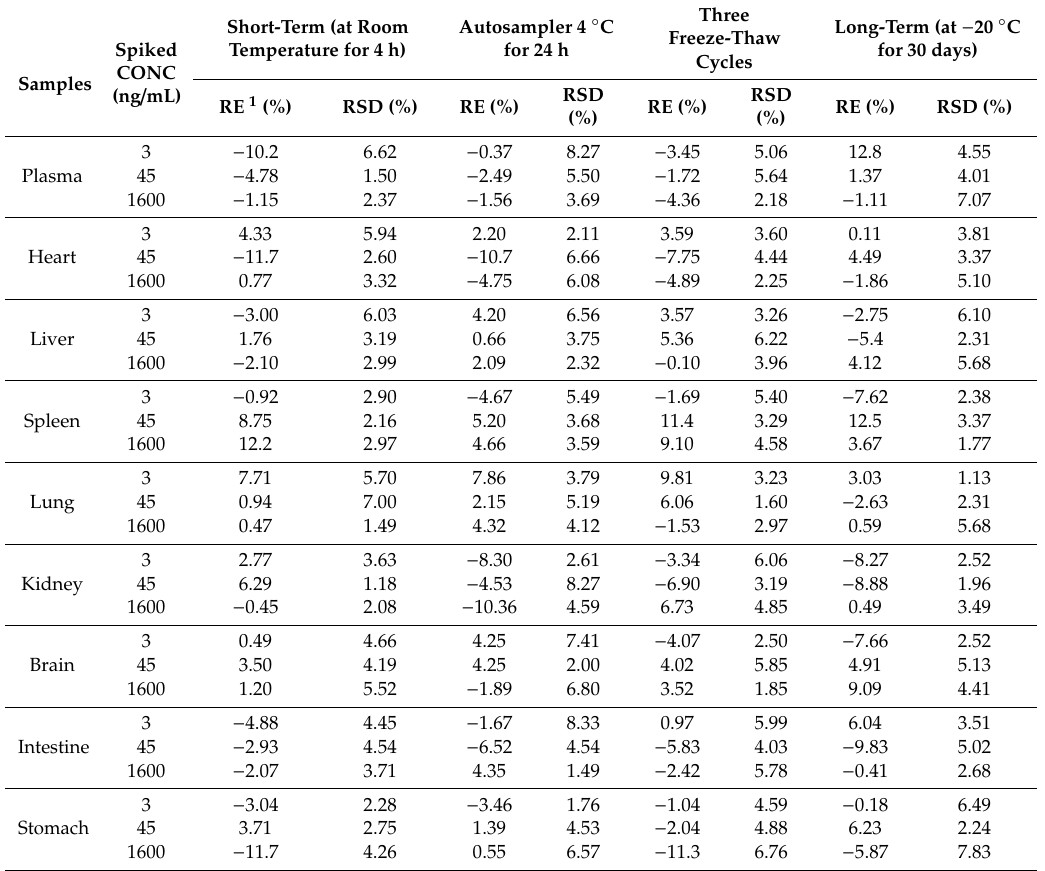
Table 5. Stability test of gardneramine in rat plasma and tissue homogenates ( n = 5).